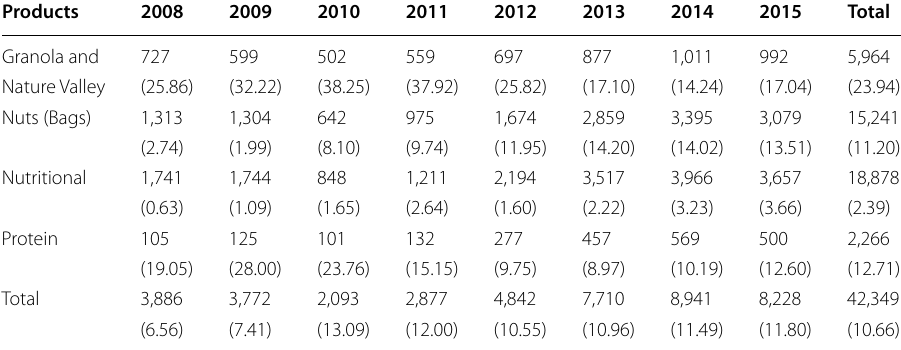
Table 2 Number of observations for each product with proportion of hemp products